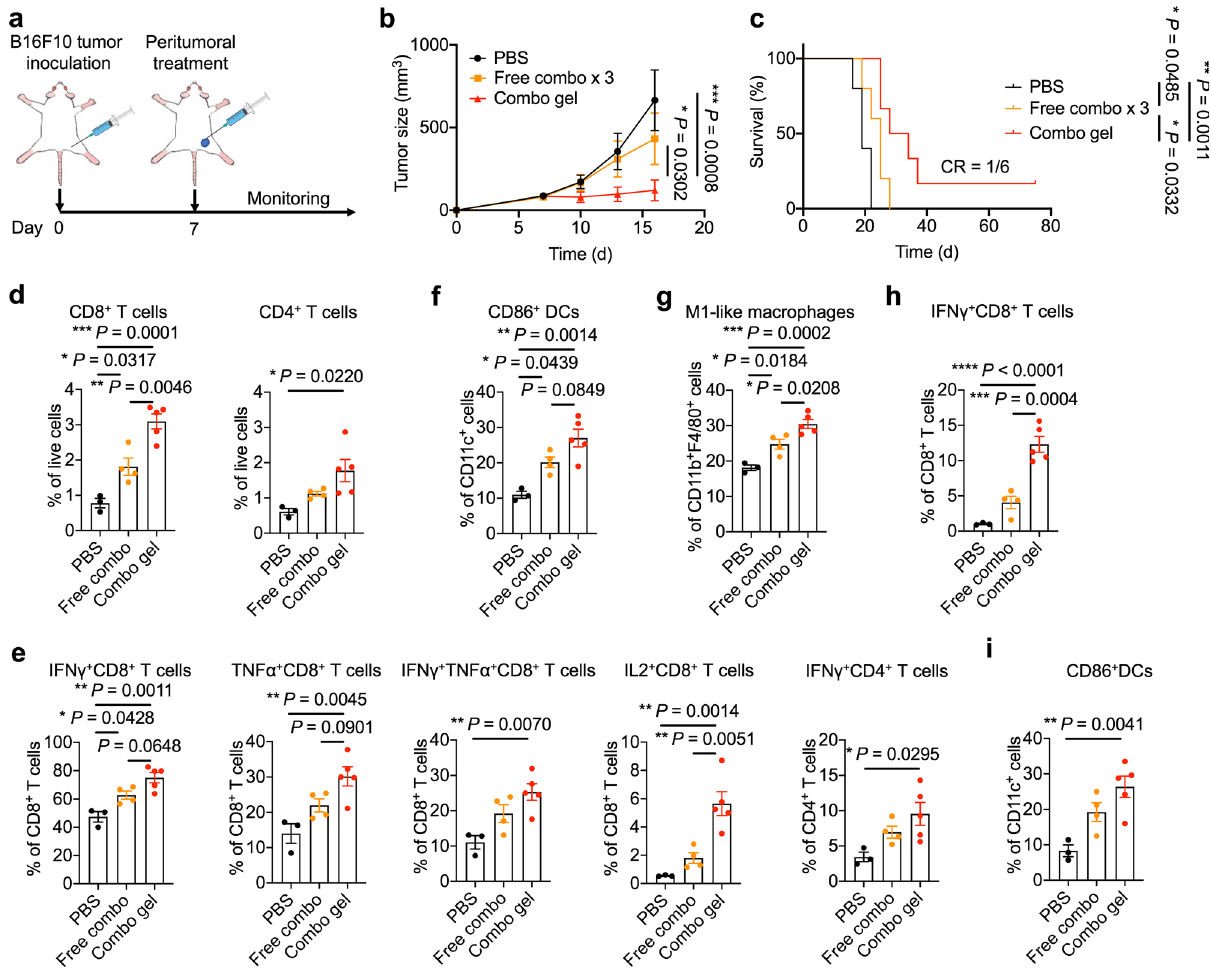
Fig. 6 Hydrogel-facilitated local administration of KYNase and Dox promotes suppression of B16F10 melanoma. a The schematics of the experiment. Mice were injected subcutaneously with B16F10 tumor cells on day 0, and treated with PBS, free KYNase and Dox administered as 3 doses, or KYNase- and Dox-loaded combination hydrogel on day 7 when tumor volumes reached 85 mm 3 . b Average tumor growth curves. n = 5 mice for PBS and free combination, and n = 6 mice for combination hydrogel. c Survival analysis for all treatment groups with fraction of complete tumor regression. d – i After B16F10 inoculation on day 0, mice were treated on day 7 when tumor volumes reached 100 mm 3 . Tumors ( d – g ) and TdLNs ( h , i ) were analyzed 4 days post-treatment. n = 3 mice for PBS, n = 4 mice for free combination group, and n = 5 mice for combination hydrogel group. d Quanti fi cation of CD8 + (left) and CD4 + (right) TILs in tumor tissues. e Quanti fi cation of IFN γ + , TNF α + , IFN γ + TNF α + , and IL2 + CD8 + TILs and IFN γ + CD4 + TILs after ex vivo stimulation. f , g Quanti fi cation of CD86 + DCs ( f ) and M1-like macrophages ( g ) in tumor tissues. h Percentage of IFN γ + CD8 + T cells in TdLNs after restimulation with B16F10 tumor cells. i Quanti fi cation of CD86 + DCs in TdLNs. Data are represented as mean ± s.e.m., and two-way ANOVA with Turkey ’ s post hoc test ( b ), one-way ANOVA with Turkey ’ s post hoc test ( d – i ) or log-rank (Mantel-Cox) test ( c ) was used. Source data are provided as a Source Data fi